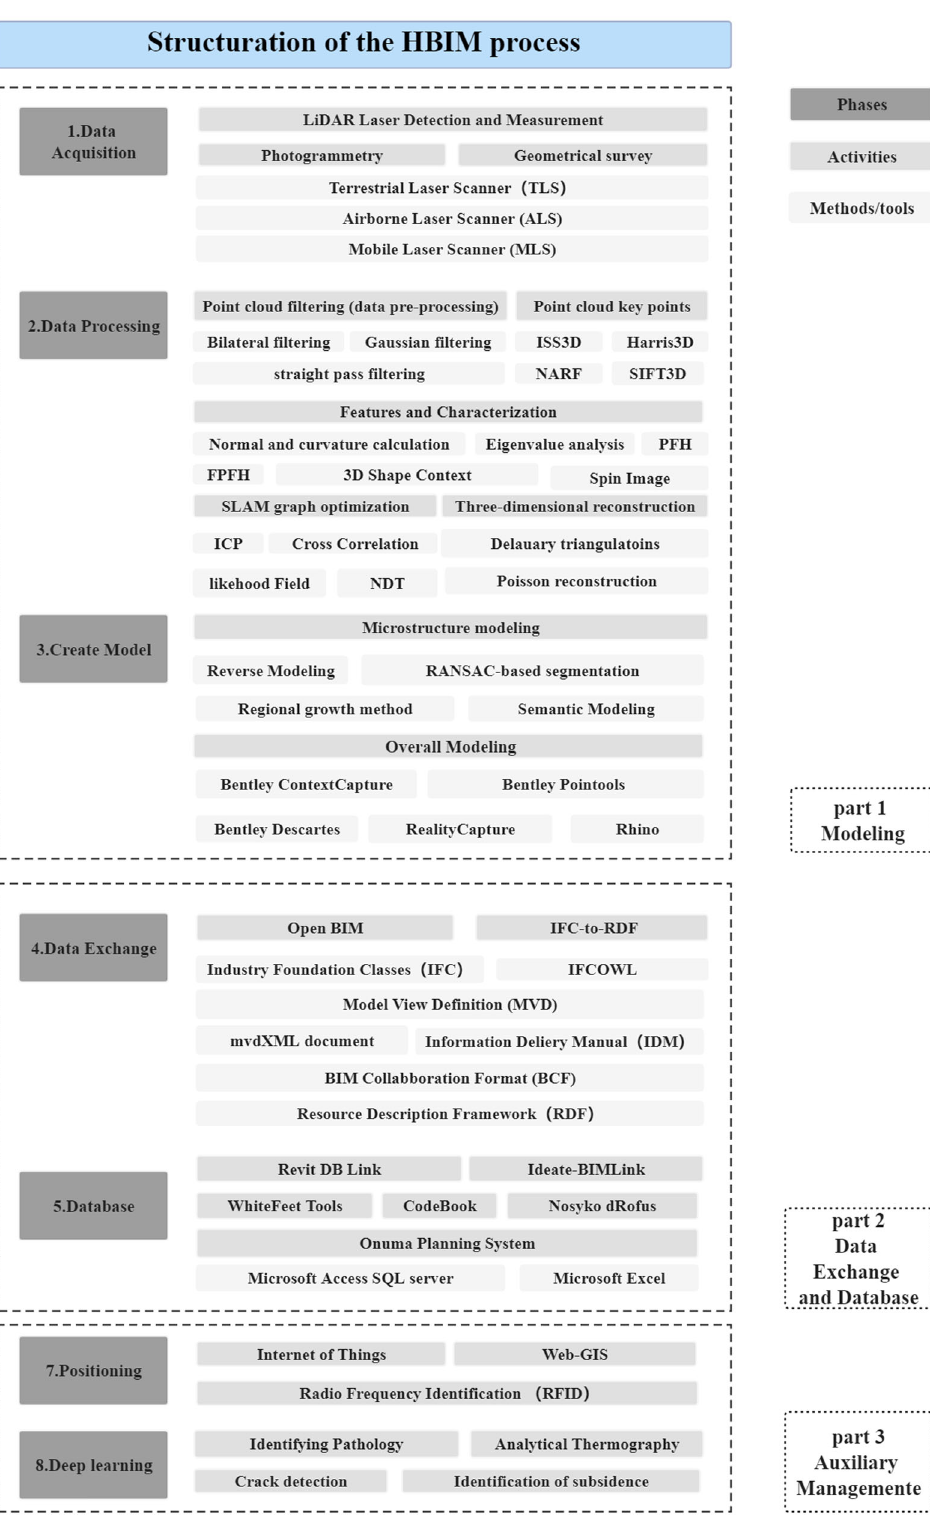
Fig. 14 Structuration of the HBIM process. HBIM application routes are obtained in combination with practical